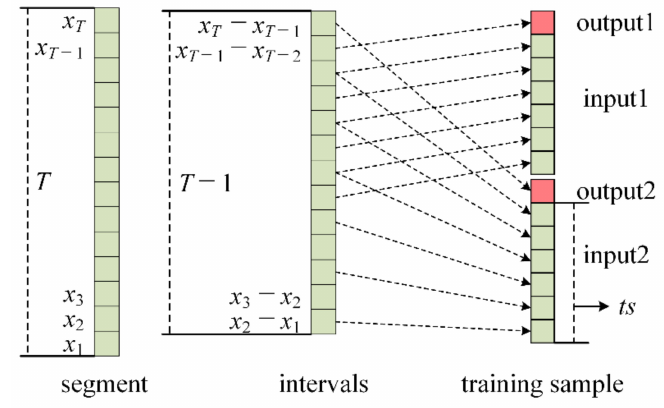
Figure 2. The minimum length of T for each